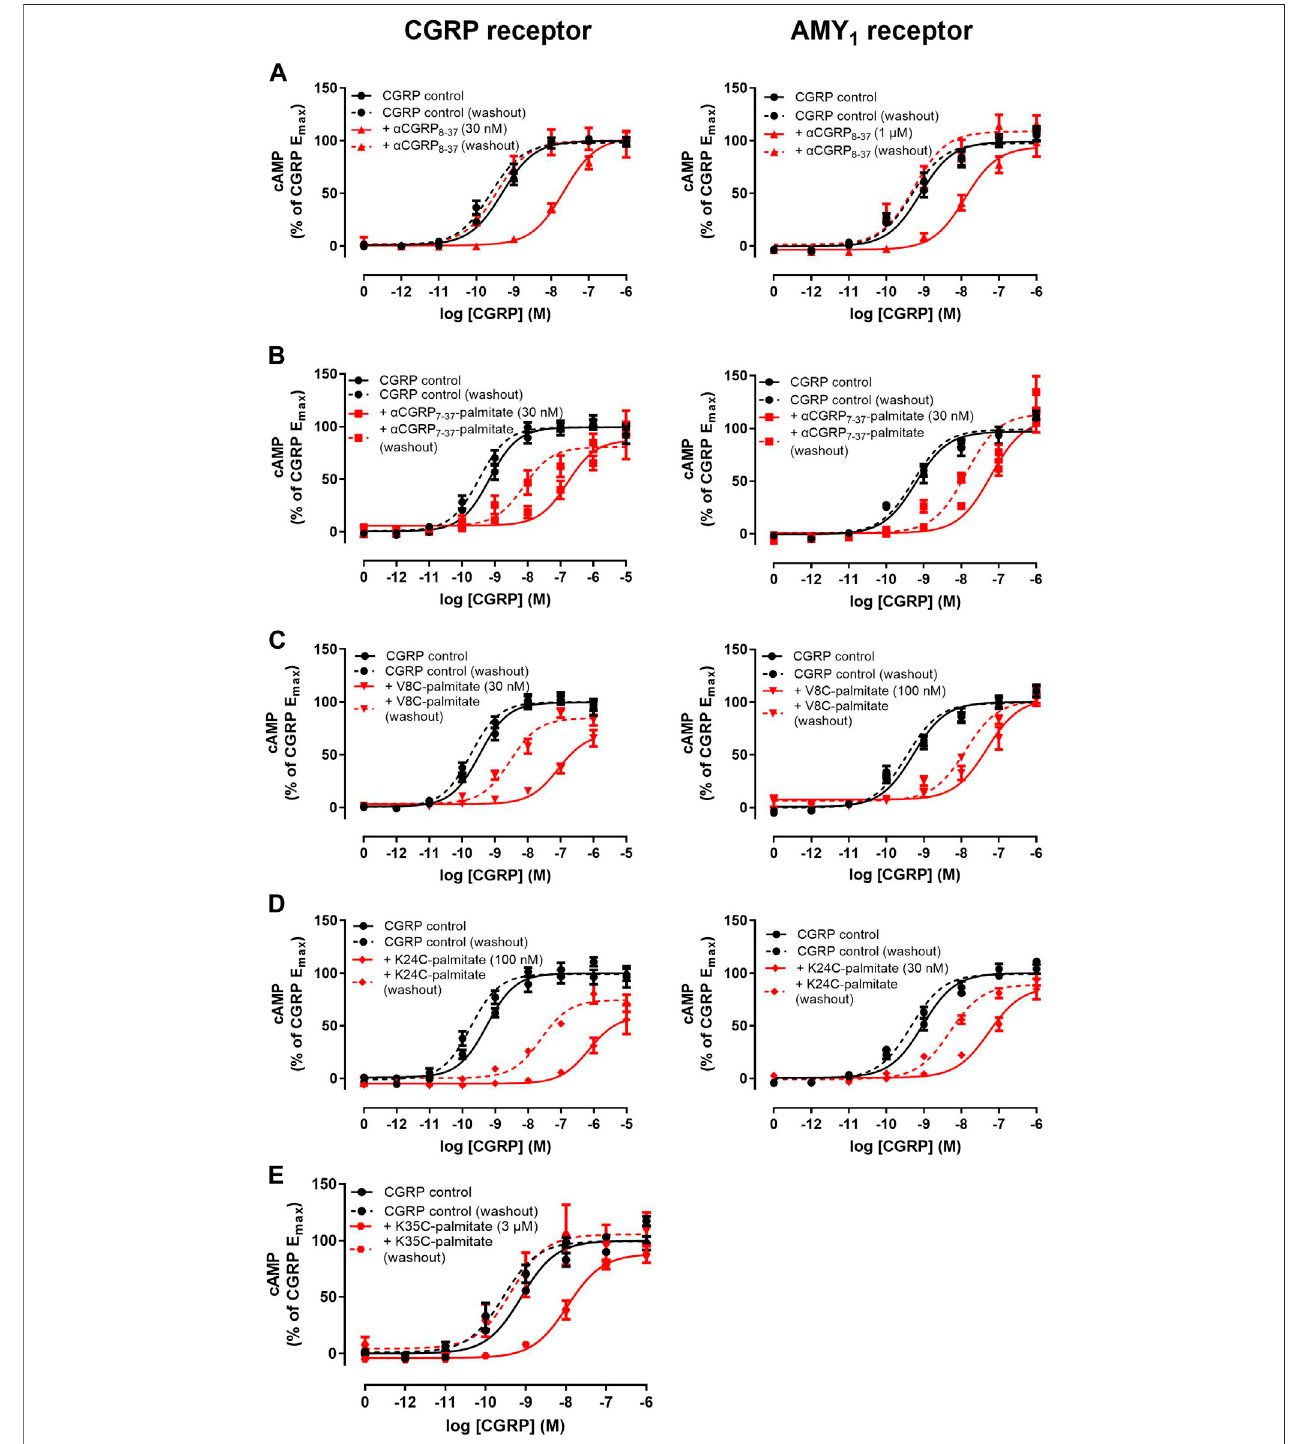
FIGURE 5 | Effect of antagonist with pre-incubation and a washout step on agonist concentration-response curves at human CGRP and AMY 1 receptors expressedinCos-7cells. (A) α CGRP 8-37 , (B) α CGRP 7-37 -palmitate, (C) V8C-palmitate, (D) K24C-palmitate, (E) K35C-palmitate.Solidanddashedlinesindicateagonist concentration-responsecurvesperformedintheabsenceorpresenceofawashoutsteppriortoagoniststimulation.Datapointsareplottedasapercentage ofmaximal CGRP-stimulated cAMP production and show mean ± SEM of fi ve independent experiments.